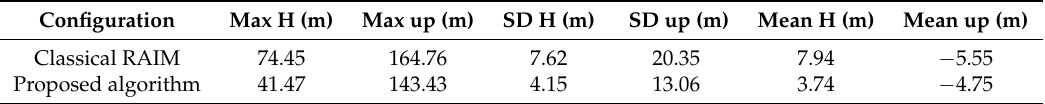
Table 10. Position error statistics considering the different solutions and all epochs. Classical RAIM is used as the term of comparison.